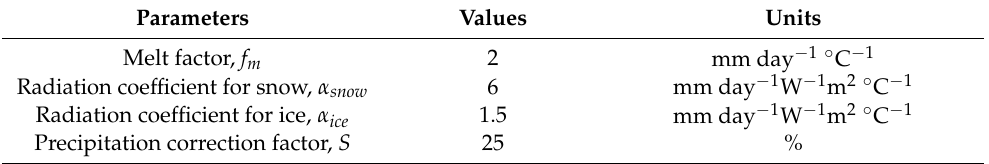
Table 5. The model parameters optimized for all mass-balance series measured in the Qiyi glacier.